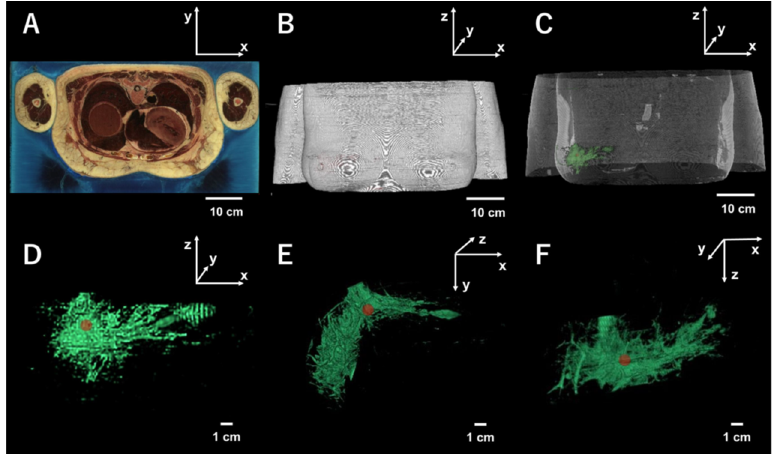
Figure 1. Visualization of the internal structure of the female breasts from the Visible Human Project (VHP). ( A ) Slice of the upper body. ( B ) Three-dimensional reconstruction of the upper body. ( C ) Internal structure in the reconstruction. ( D ) Enlarged internal structure with fluorescence-labeled cancer with 1 cm diameter. ( E ) The 3-D vision of the enlarged structure is observed from a different angle. ( F ) 3-D vision from another different angle. See text.